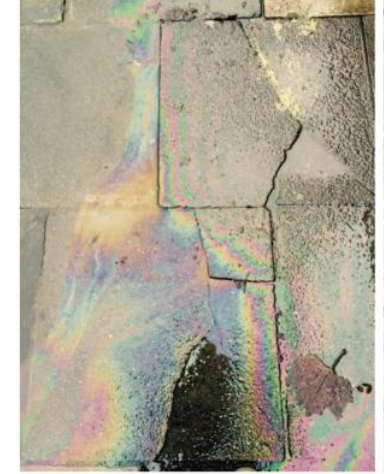
Figure 11. Oil traces on Car Park Beach.